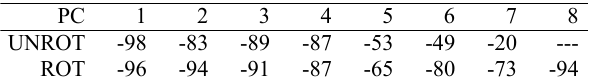
Table 5. Pattern correlations (x100) between positive and negative composite PV anomaly maps at 650K for 8 unrotated PCs (UN- ROT) and 8 rotated PCs (ROT) in NH. No pattern is classified with the negative type 8, so the correlation cannot be calculated